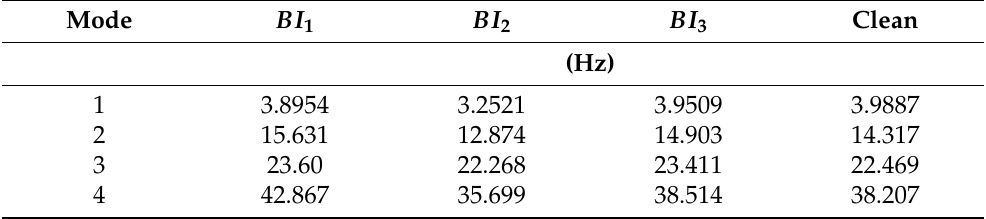
Table 3. Comparative analysis of modal frequencies of the eroded and the clean